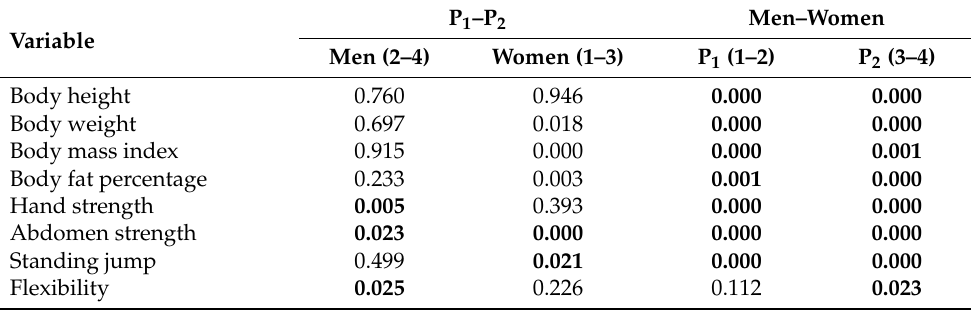
Table 4. Post hoc test results ( p